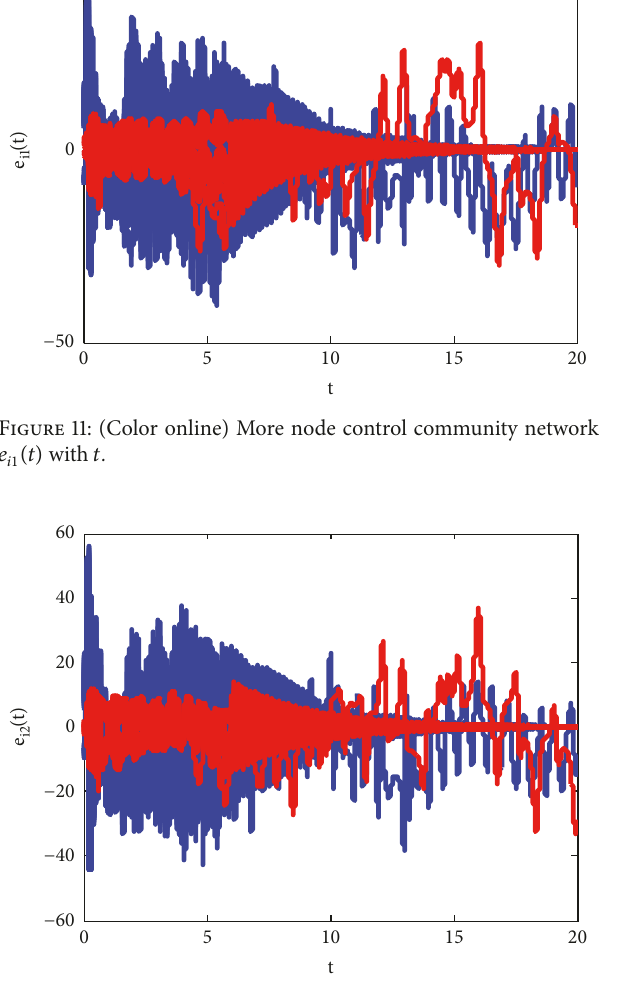
Figure 12: (Color online) More node control community network 𝑒 (𝑡) with 𝑡 . 𝑖2